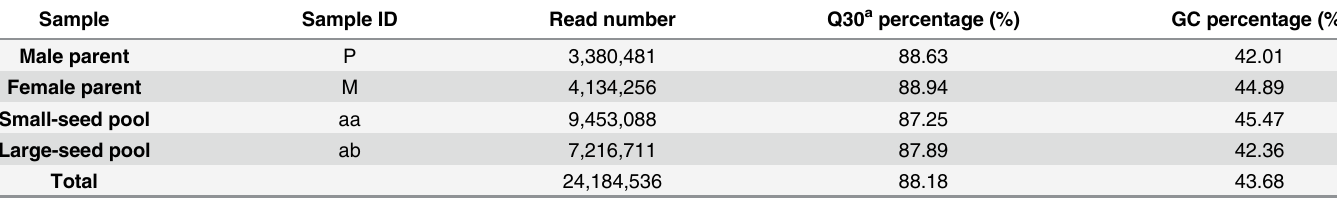
Table 1. Statistic results of sequencing data for both parents and bulked DNA pools.